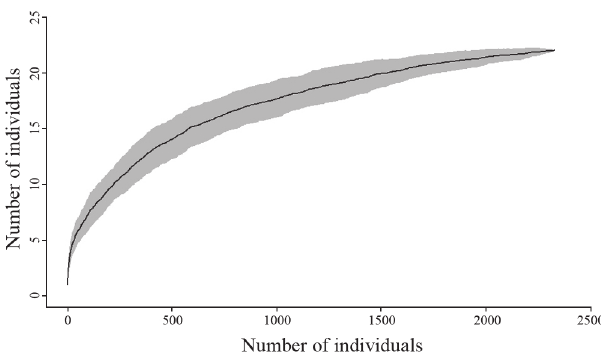
Fig. 2. Species accumulation curve and standard error (gray) generated from permutations of sampled individuals in streams of the APA Gama and Cabeça de